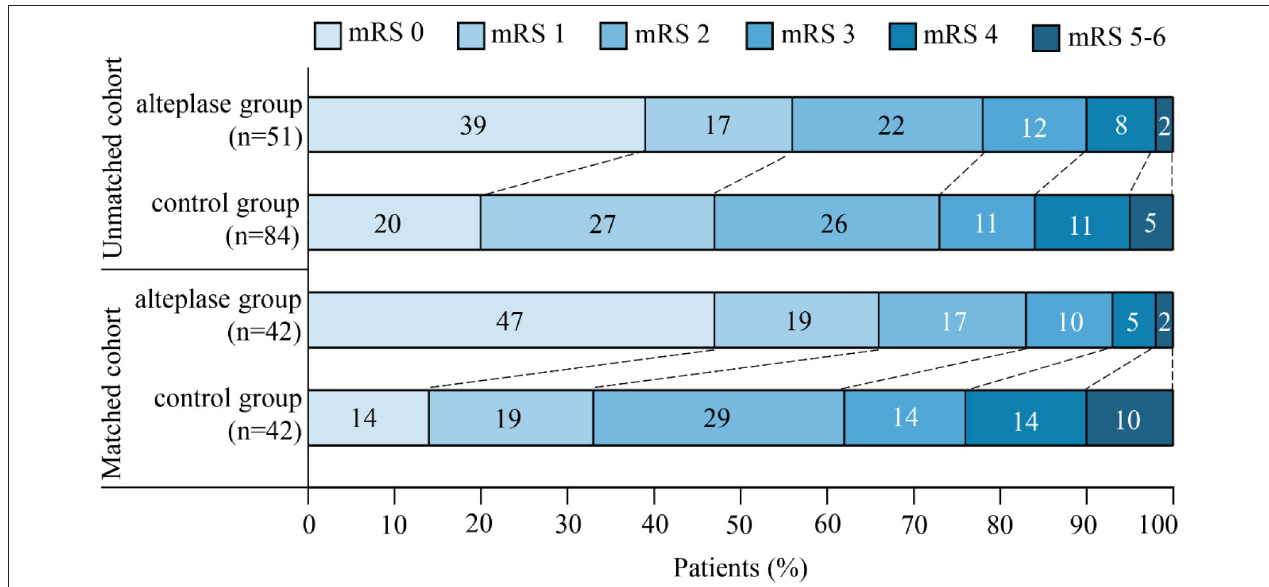
FIGURE 3 | The distribution of scores on the modified Rankin scale (mRS) at 3 months after stroke was in favor of intravenous thrombolysis. The mRS scores ranged from 0 to 6, in which higher scores indicated more severe disability.